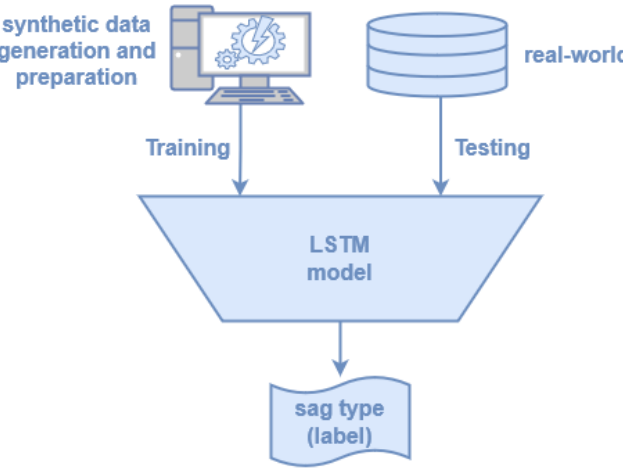
Figure 2. Overview of the experimental setup.